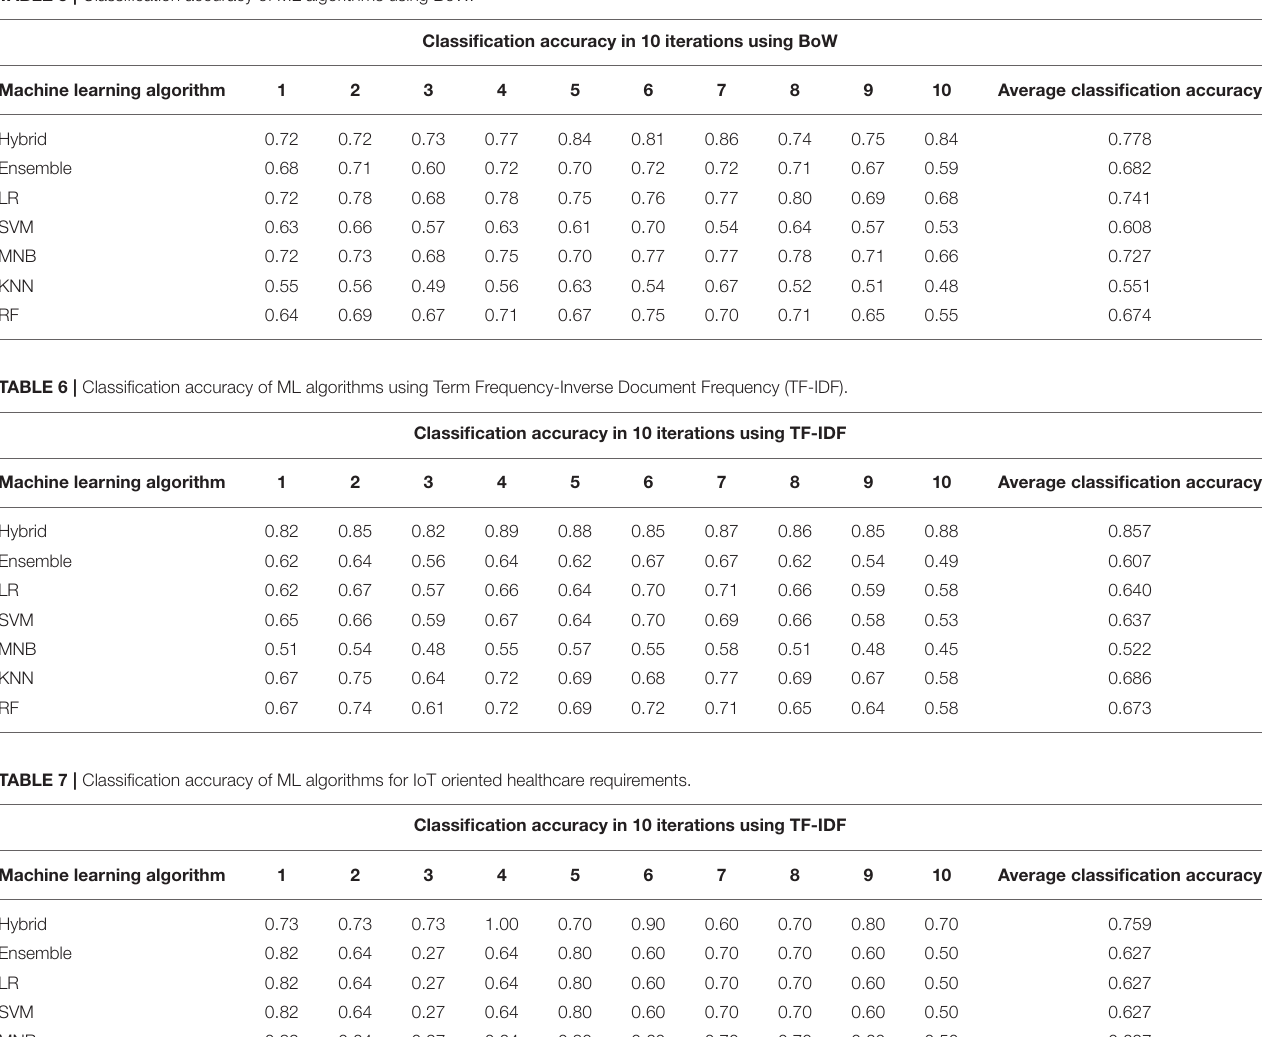
TABLE 5 | Classification accuracy of ML algorithms using BoW.